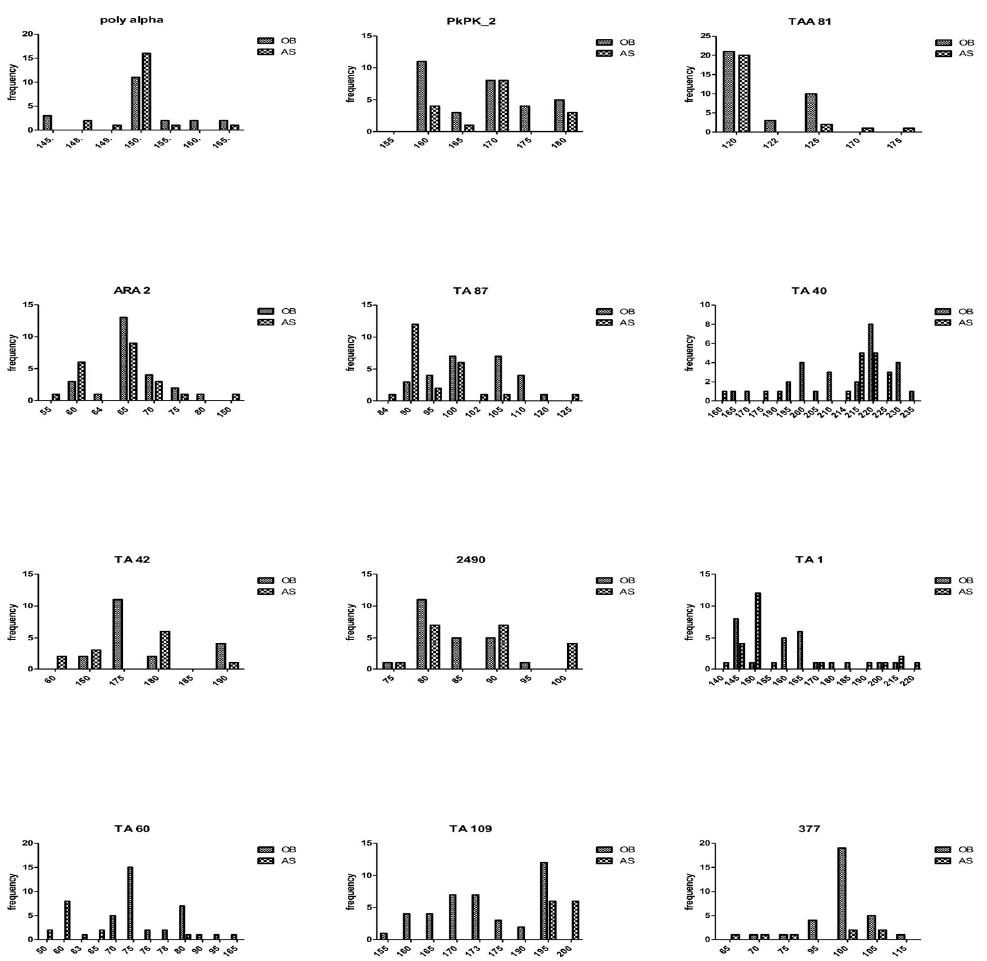
Figure 4. Allelic diversity at the 12 microsatellite markers. Alleles (vertical axis) were scored by GeneMapper v5 and GenAIEx and used to generate allelic frequencies (Obom in blue and Asutsuare in orange bars) in both populations.